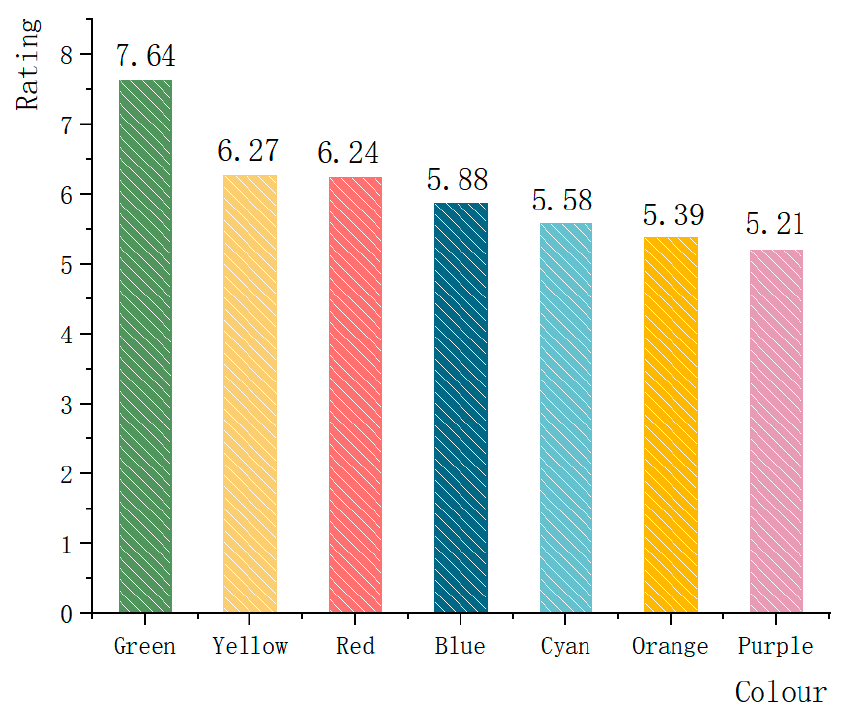
Figure 12. Likert scale healing rating trend chart. Source: Likert scale, colour healing rating of seven types of landscapes, and the figure shows the overall mean trend of subjects’ scores.